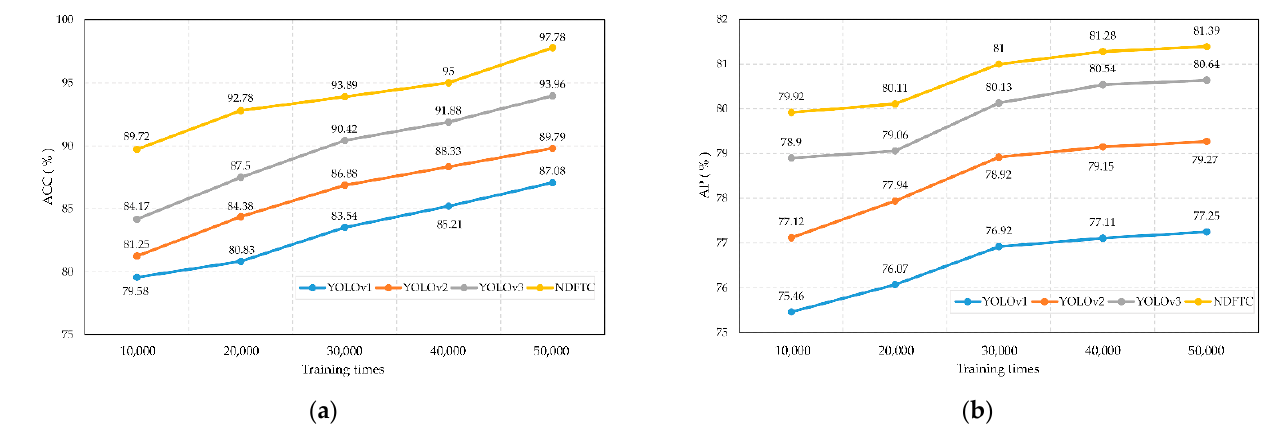
Figure 4. Performance of NDFTC and other models with ACC and AP: ( a ) ACC of NDFTC and other models; ( b ) AP of NDFTC and other models.